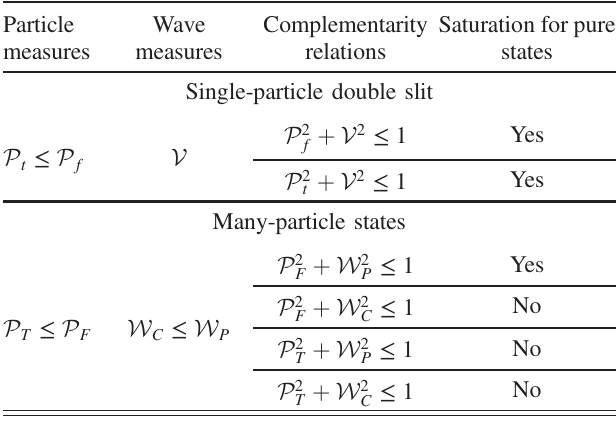
TABLE I. Overview of complementarity relations for the single-particle double-slit experiment and for states of many partially distinguishable